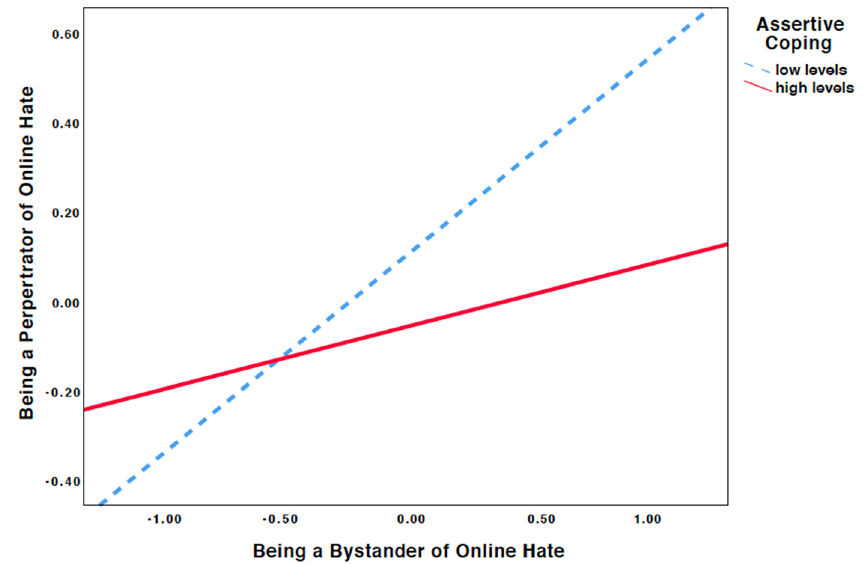
Figure 1. Simple slopes equations of the regression of online hate bystanders on online hate perpetrators at high and low levels of assertive coping.